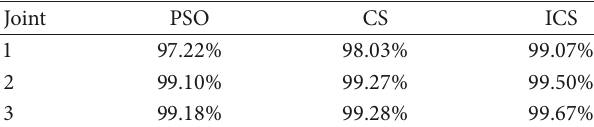
Table 4: Comparison of the correlation